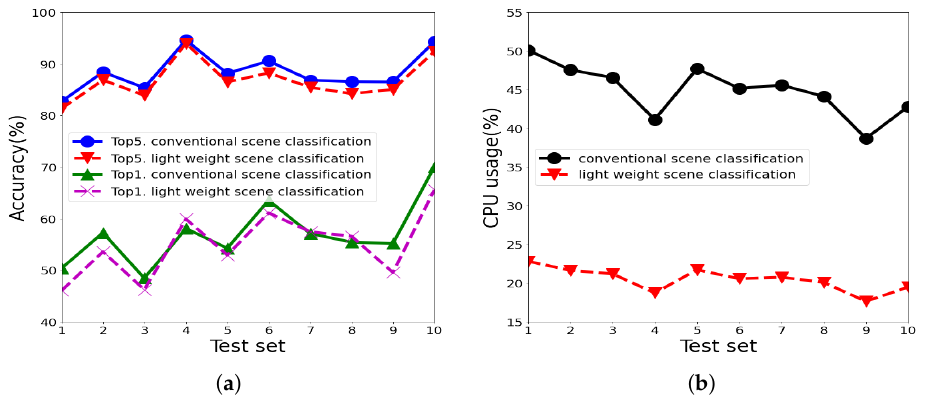
Figure 11. Performance analysis of lightweight scene classification: ( a ) Detection accuracies for Top1 and Top5, ( b ) CPU